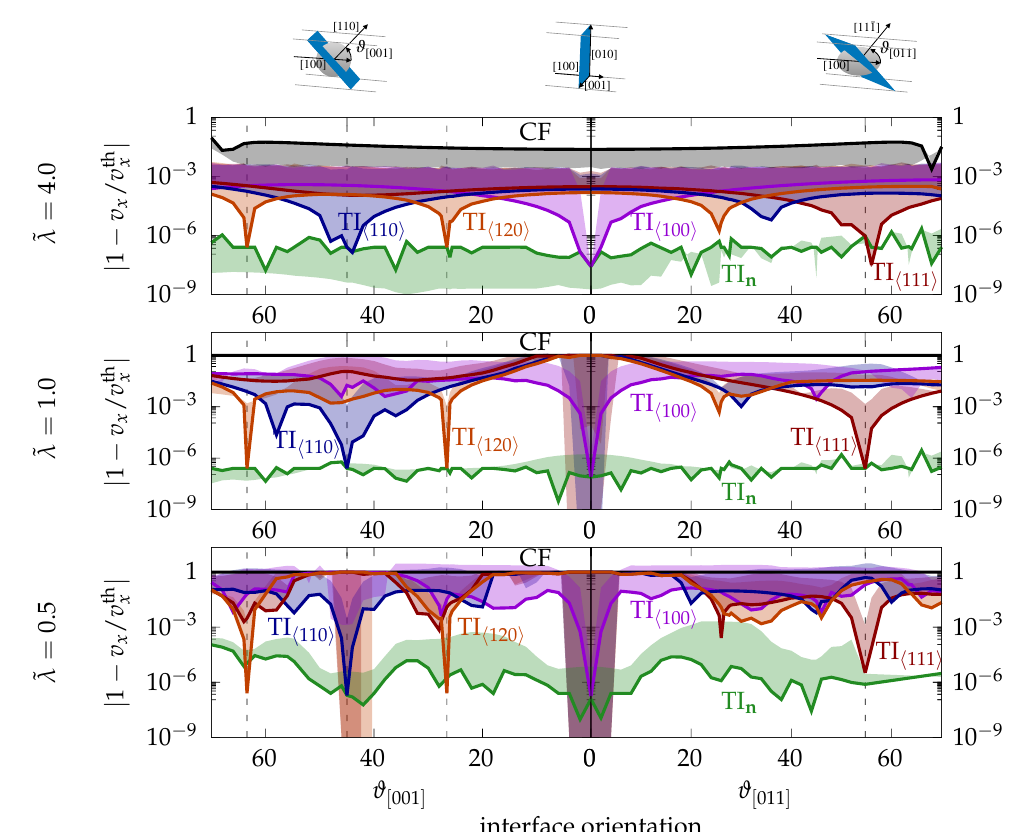
Figure 8. The relative error in the x − component of the stationary velocity as functions of the interface orientation angles ϑ [ 001 ] and ϑ [ 011 ] . The results from the continuum field (CF) model, various TI (cid:104) hkl (cid:105) models and the TI n model are compared for three different profile resolutions ˜ λ = 4.0, ˜ λ = 1.0 and ˜ λ = 0.5. The imposed driving force decreases with increasing orientation angles, i.e., µ = µ with ˜ µ 0 = ∆ x µ 0 / Γ = 0.1 and in any case h 3 . The time discretization is M µ 0 ∆ t / ( Γ∆ x ) = 10 − 6